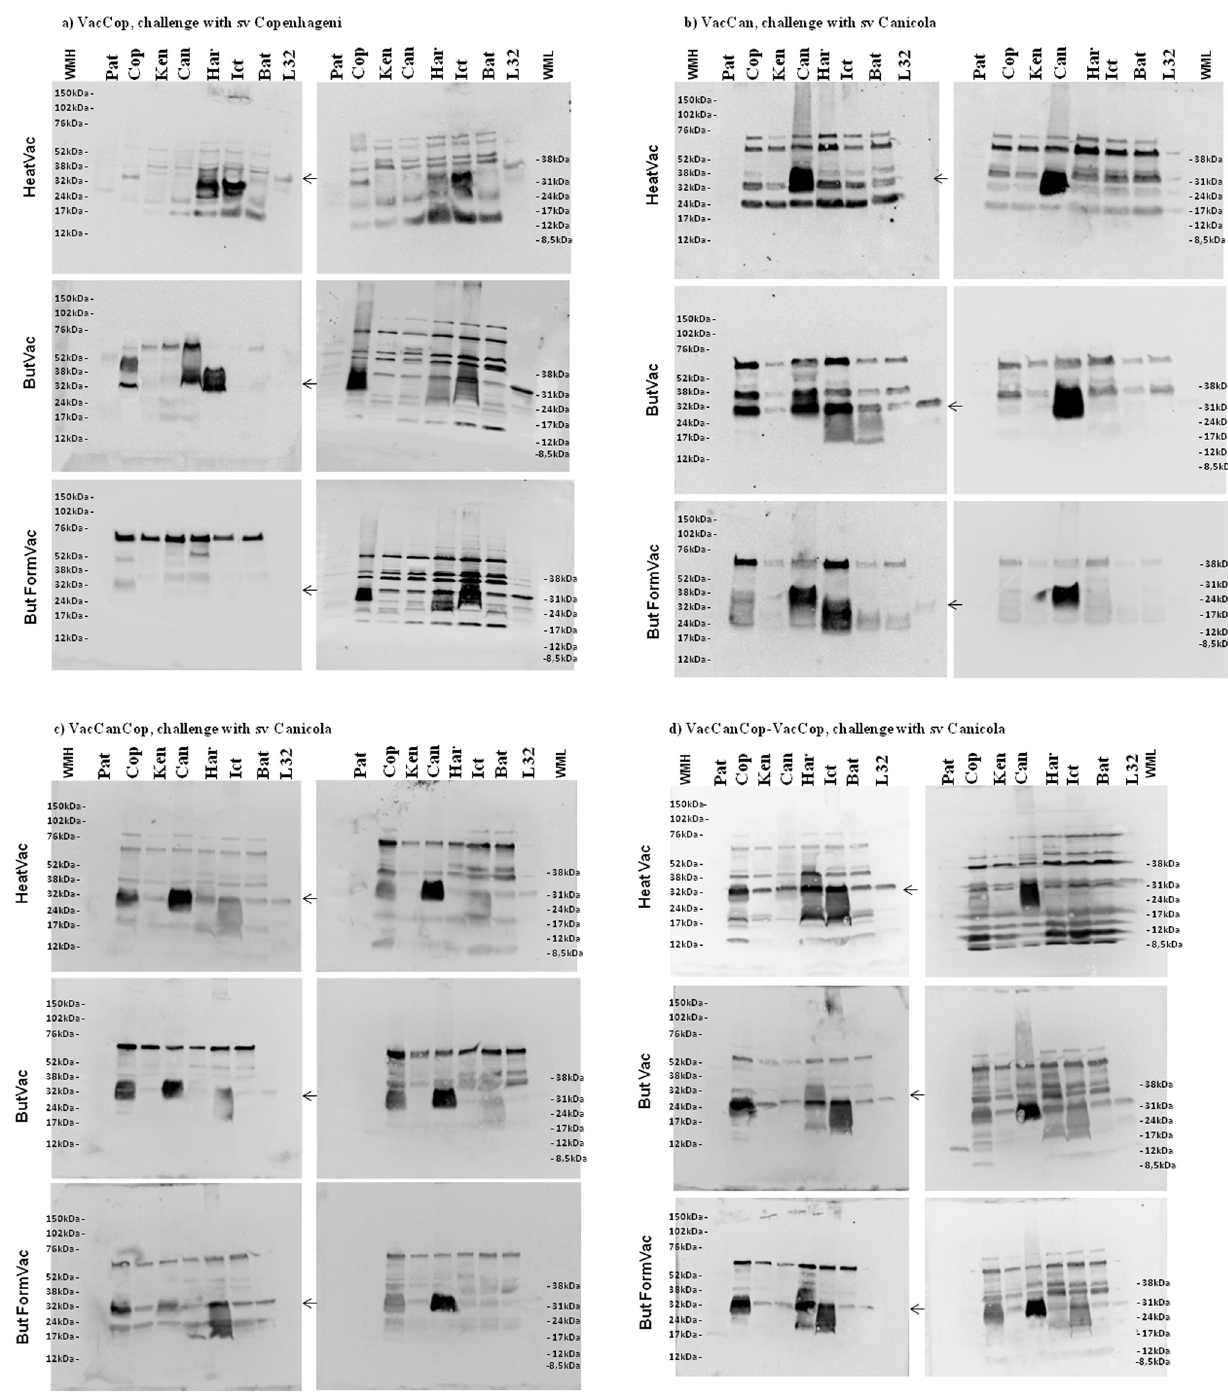
Fig 2. Western blotting of antisera obtained from hamsters immunized and challenged with L . interrogans serovar Copenhageni or Canicola, analyzed against cell extracts from different Leptospira species and serovars. Western blot images were obtained using sera collected from animals of different experimetal groups fifteen days after second dose immunization (left side) and thirty days after challenge (survivor animals) (right side). Immunization and challenge groups as indicated: a) VacCop challenge sv Copenhageni; b) VacCan challenge sv Canicola; c) VacCanCop challenge sv Canicola and d) VacCanCop first dose, VacCop second dose challenge Canicola. Different Leptospira cell extracts were prepared, separated by SDS-PAGE in 4–20% gradient gels (except Fig d HeatVac right, that was performed with 12% polyacrylamide). Pat— L . biflexa sv. Patoc; Cop— L . interrogans sv. Copenhageni; Ken— L . interrogans sv. Kennewich (Pomona LPF); Can— L . interrogans sv. Canicola (LO4); Har— L . interrogans sv. Hardjo (strain Hardjoprajitino); Ict— L . interrogans sv. Icterohaemorrhagiae (strain M20); Bat— L . interrogans sv . Bataviae (strain Van Tienen); L32—LipL32 recombinant protein; LMW—Low-Range and HMW—Full-Range (ECL Rainbow Molecular Weight Marker (GE Healthcare).